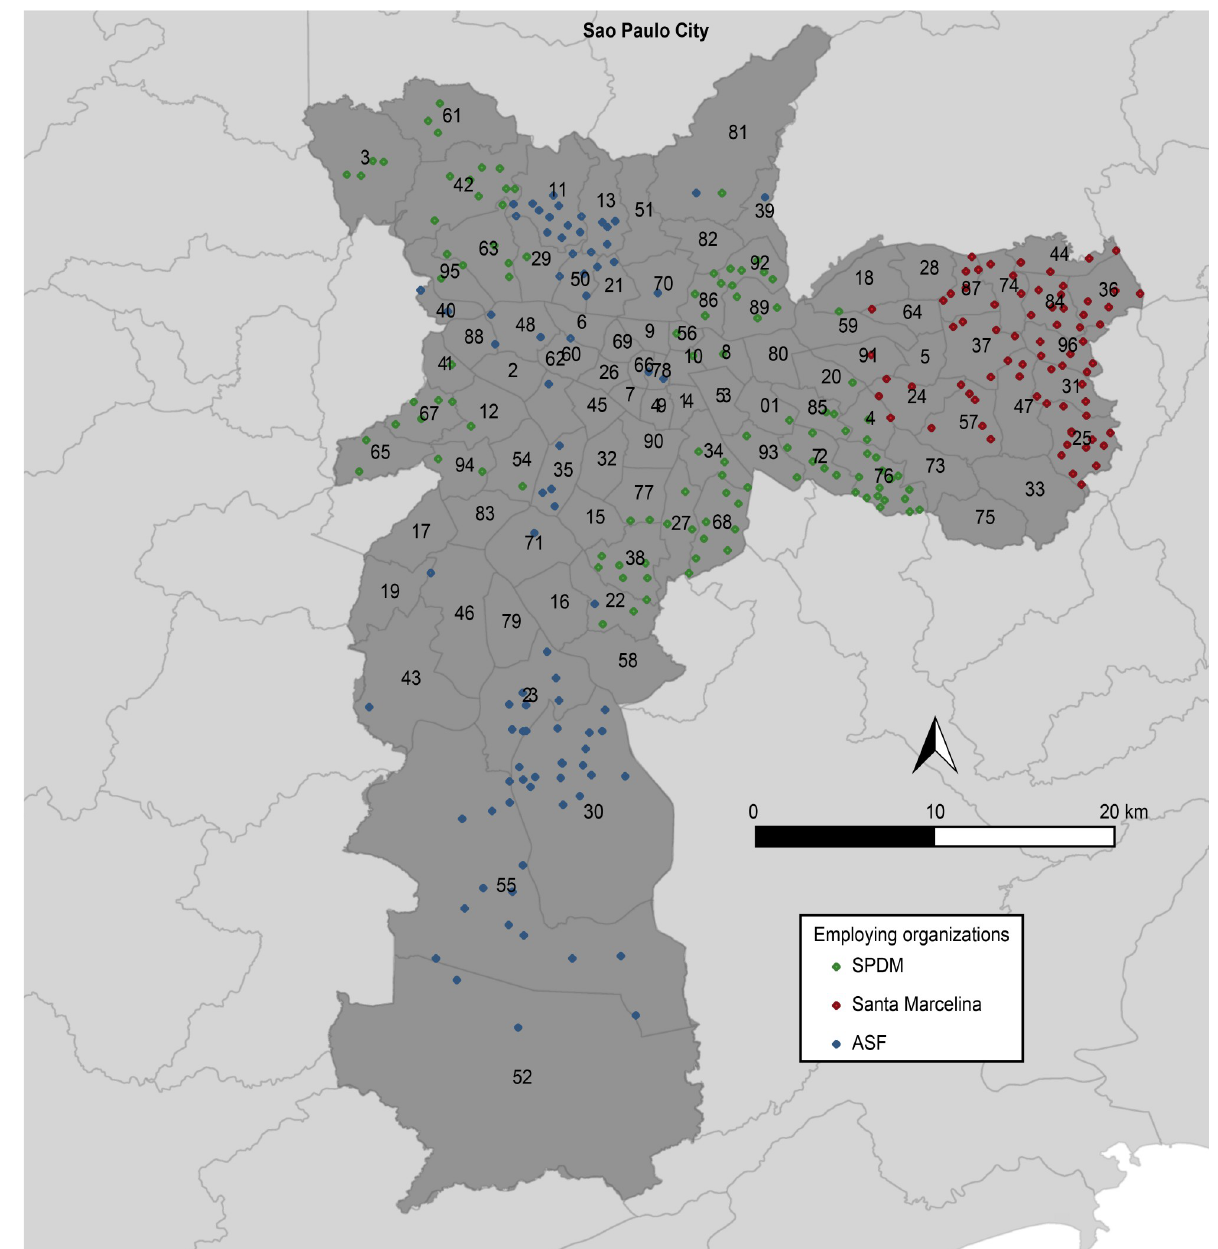
Fig 1. Distribution of the 284 primary health care units according to the employing